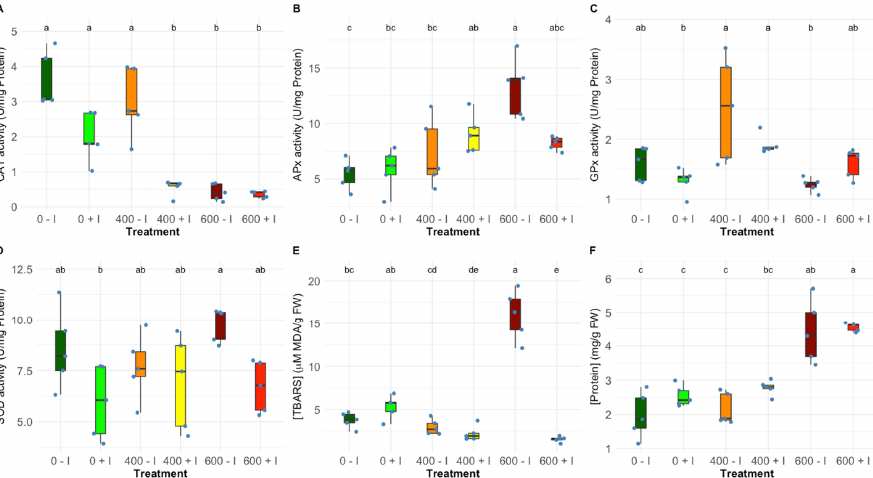
Figure 5. Oxidative stress biomarkers, ( A ) catalase (CAT), ( B ) ascorbate peroxidase (APx), ( C ) guaiacol peroxidase (GPx), and ( D ) superoxide dismutase (SOD) activities (U mg − 1 protein) and ( E ) thiobarbi- turic acid reactive substances (TBARS; µ M MDA g − 1 FW) and ( F ) total protein content (Protein; µ g Protein g − 1 FW) in non-inoculated and inoculated Halimione portulacoides individuals (N = 5), along with the tested NaCl concentrations. Letters indicate significant differences between treatments at p <